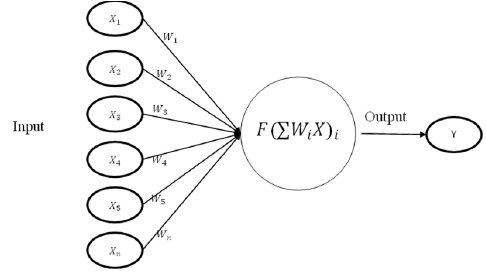
Fig. 4. Building block of the neural